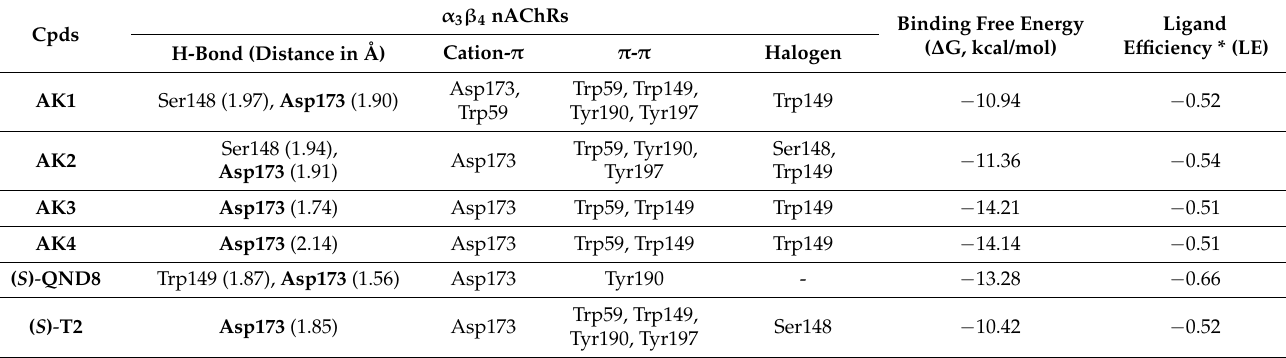
Table 2. The amino acid residues involved in the binding interaction to α 3 β 4 nAChRs.